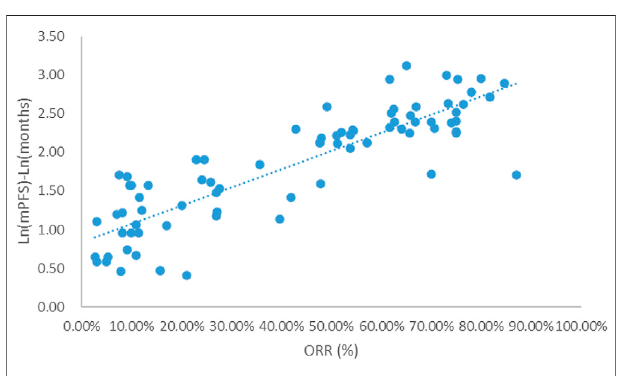
FIGURE 4 | Linear fi tting results for ORR and ln (mPFS).